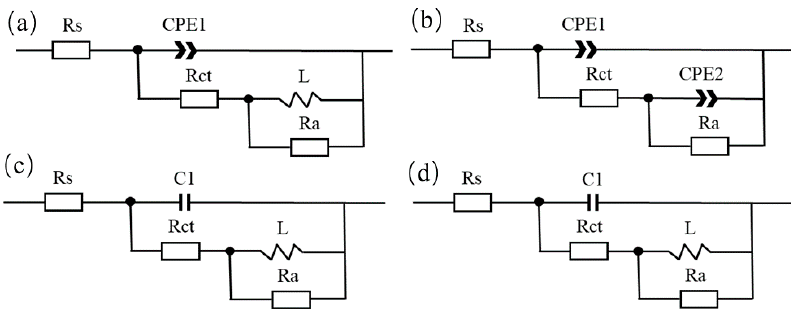
Figure 9. The EC were used for fitting the impedance data of samples; ( a – d ) are samples 1, 2, 3, and 4, respectively, after the electrochemical test.